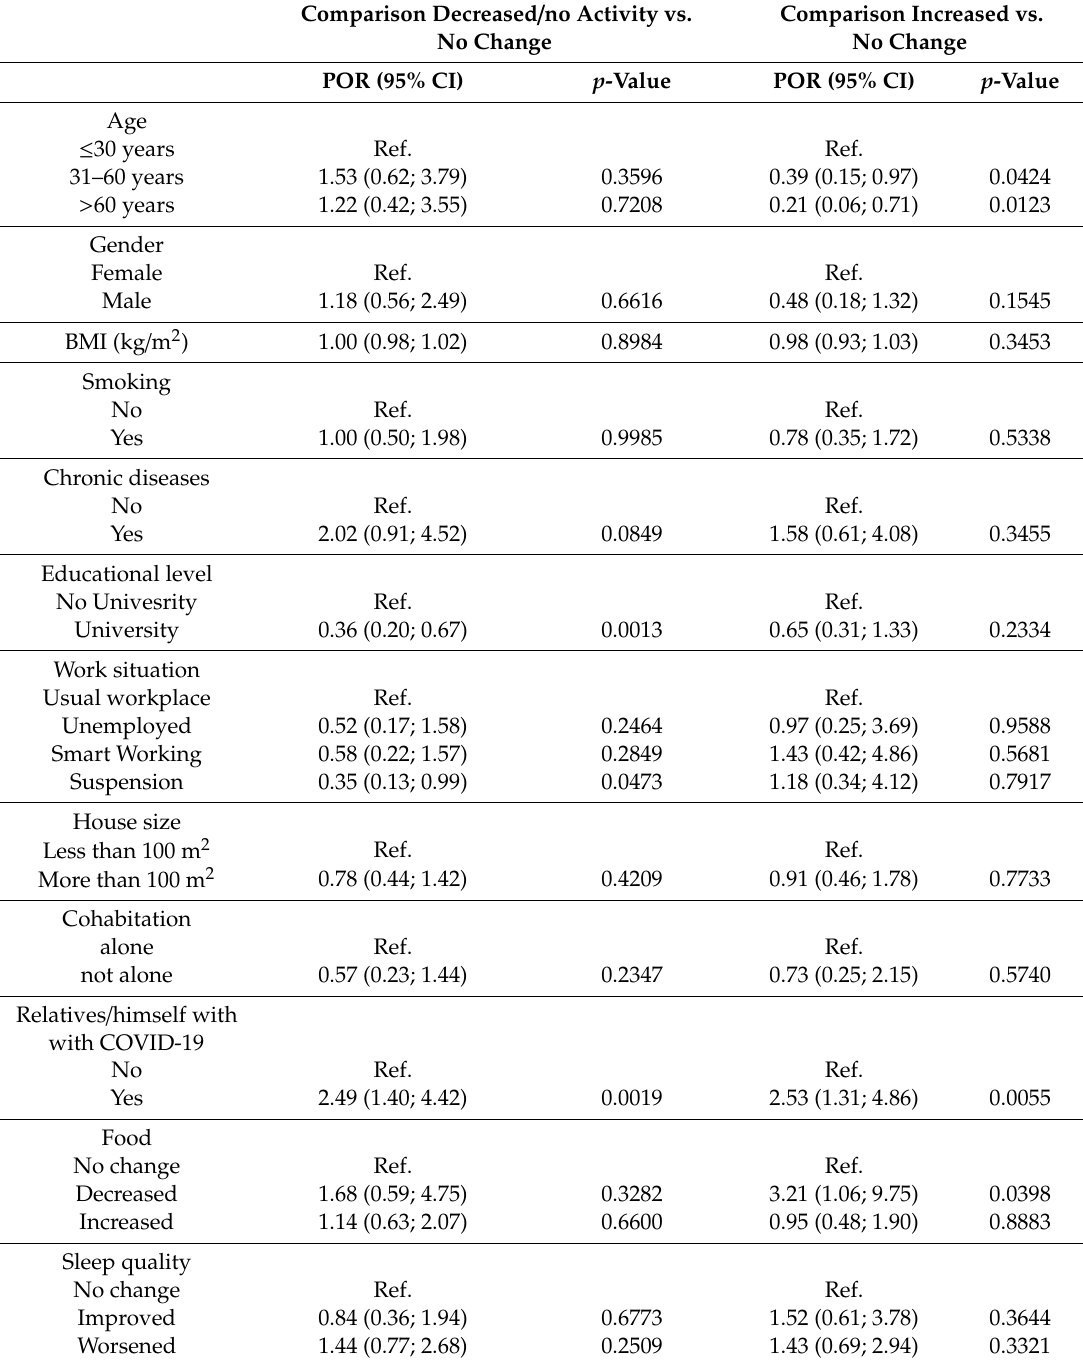
Table 3. Prevalence Odds Ratio (POR) for changes in physical activity. Comparison Decreased / no Activity vs. Comparison Increased